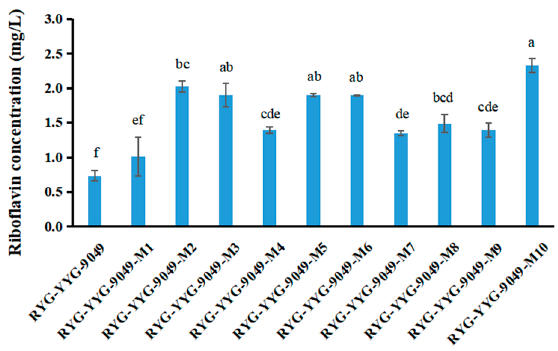
Figure 3. The concentration of riboflavin produced by the RYG-YYG-9049 strain and its ten mutant strains. Values with different lowercase letters indicate statistical significance ( p < 0.05).